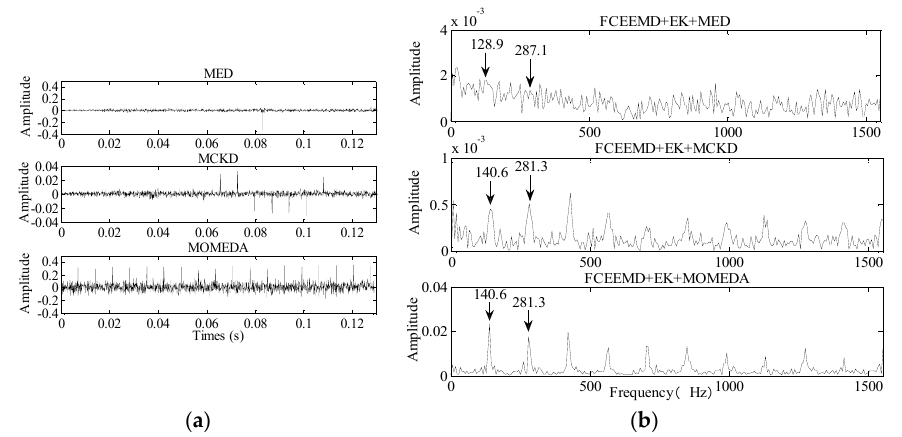
Figure 24. The time domain diagram and envelope spectrum of the impact signals obtained by the three methods. ( a ) Time domain diagram of three groups of impact signals. ( b ) Envelope demodulation of three groups of impact signals.